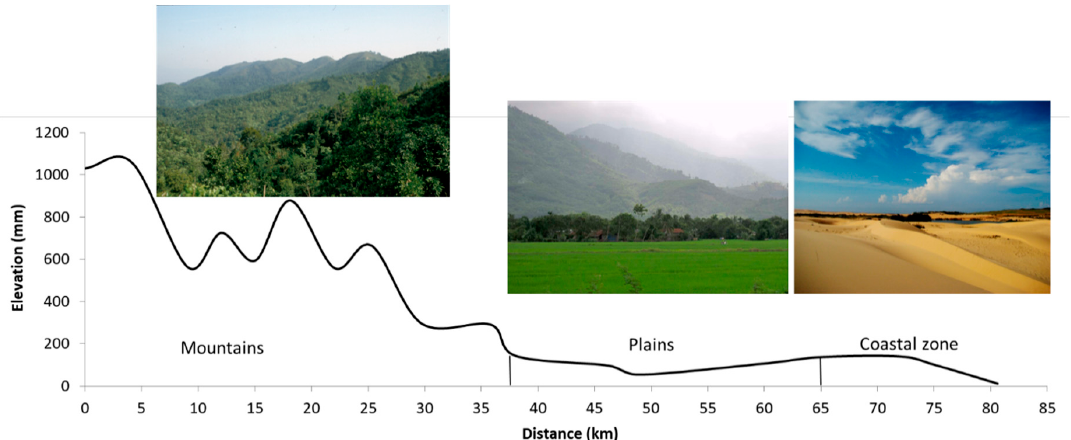
Figure 3. Transect showing major landforms and land degradation in relation to vegetation, soil, land management and agricultural crops. The location of the transect with its distance from west to east is shown in Figure 2. Table 2. Major landforms and their natural resources, degradation and land use in Binh Thuan province.